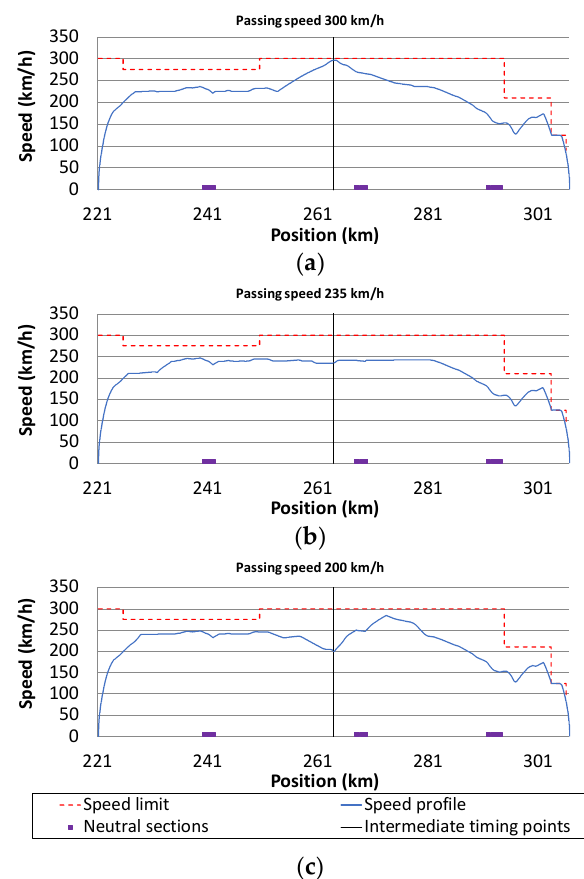
Figure 4. Speed profiles obtained optimizing independently each section between target times fixing the passing speed at 264 km to 300 km/h ( a ), 235 km/h ( b ) and 200km/h ( c ). Table 4. Results of the speed profiles obtained for different values of passing speed at 264 km.